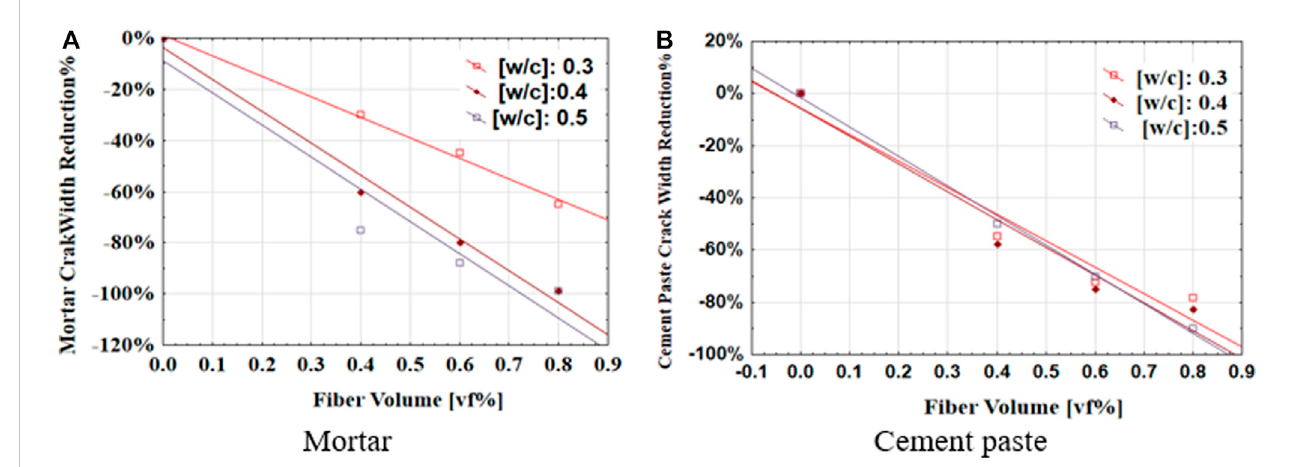
FIGURE 13 Crack-width reduction percentage at different w/c with different fi bre V f for (A) Mortar and (B) Cement paste.